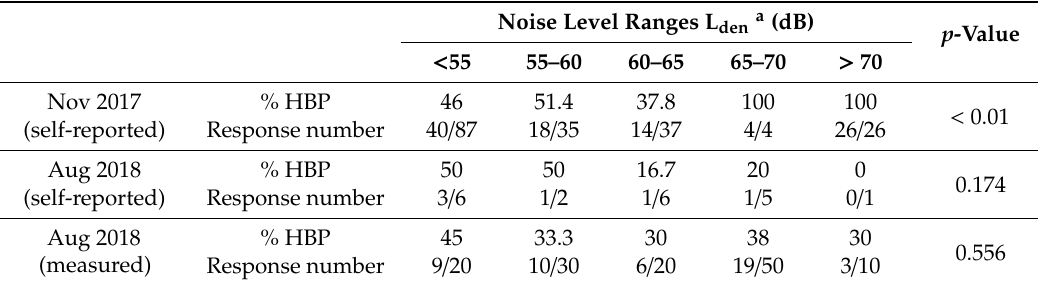
Comparison of high blood pressure ratios at di ff erent noise level ranges of